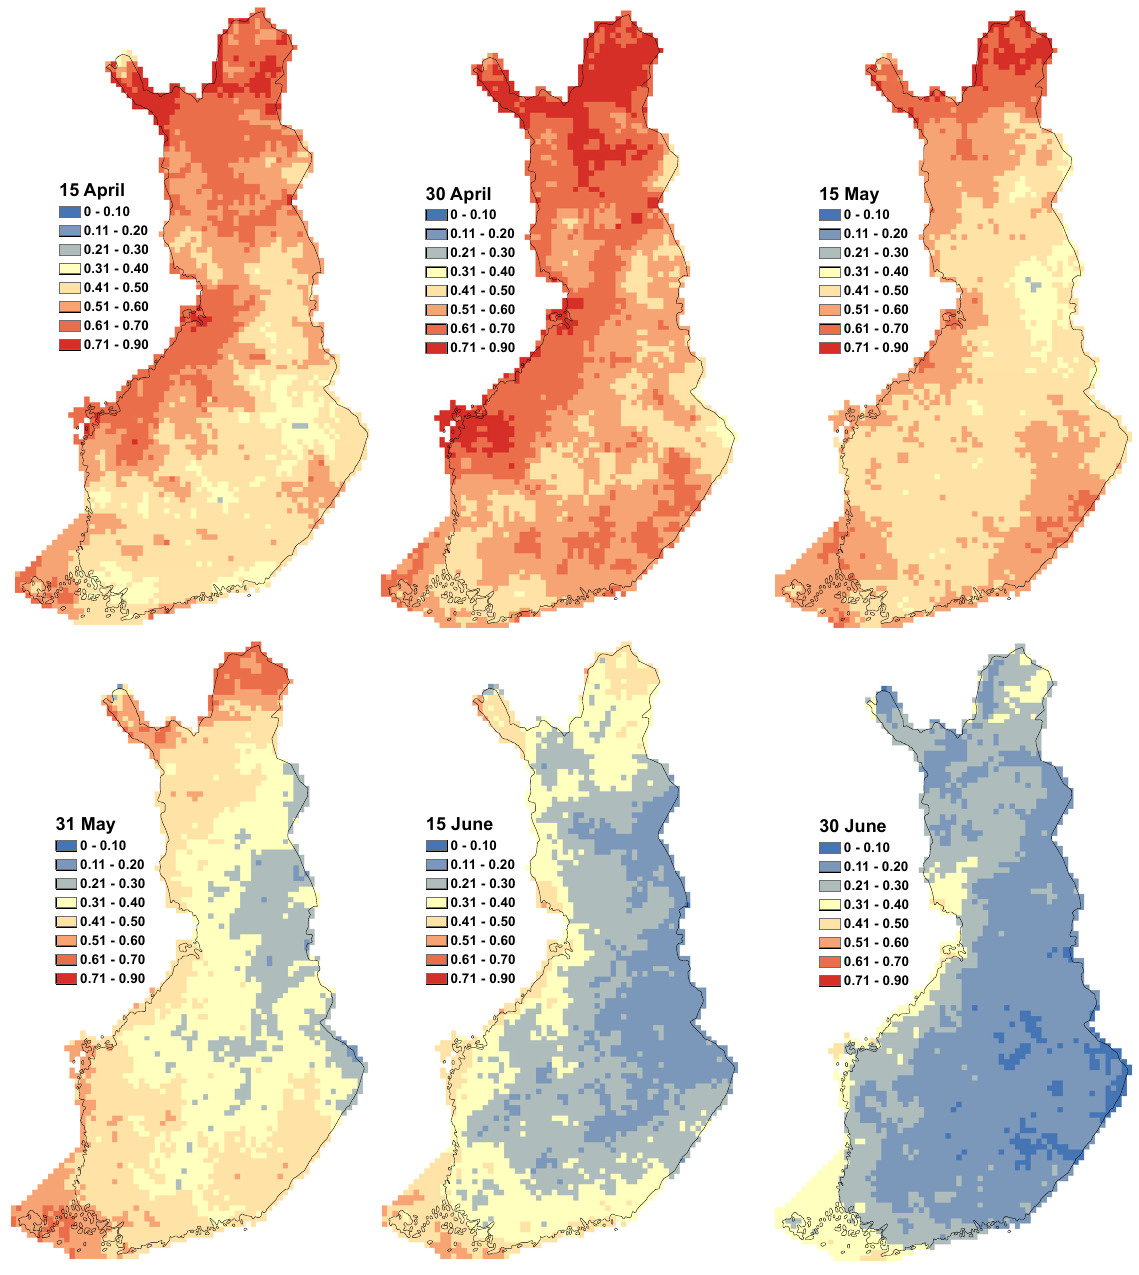
Fig. 2a. Probabilities of drought lasting for at least three weeks for the periods that ended on 15 April to 30